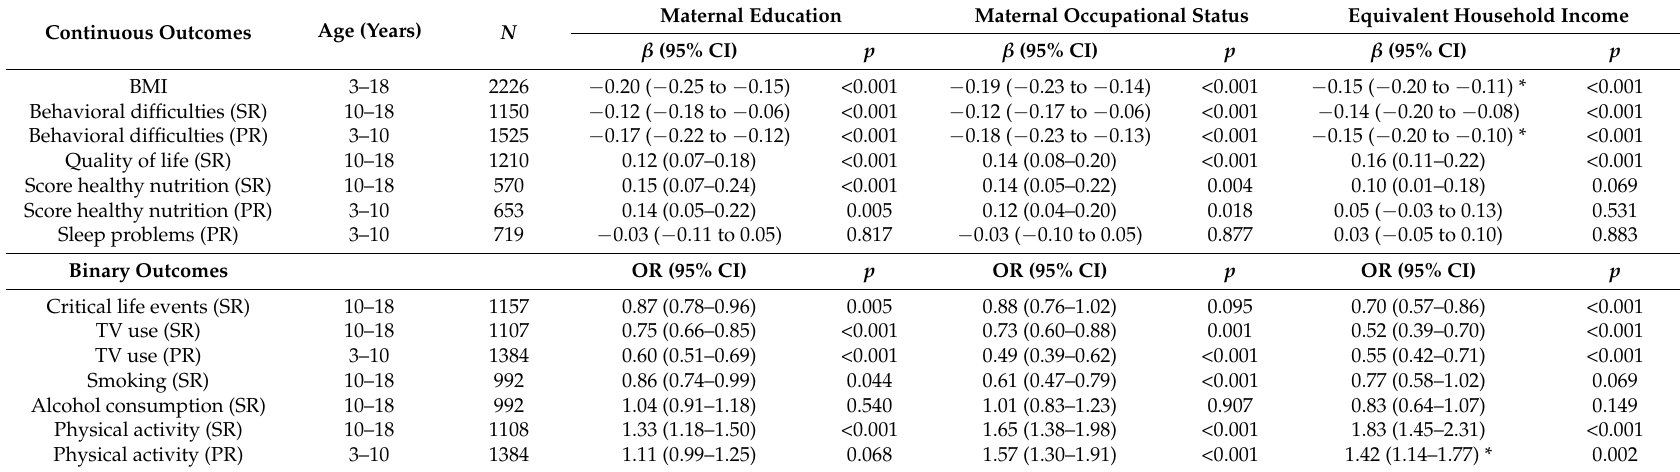
Table 4. Associations of different health outcomes and behaviors with children’s SES (as indicated by maternal education, maternal occupational status, or equivalent household